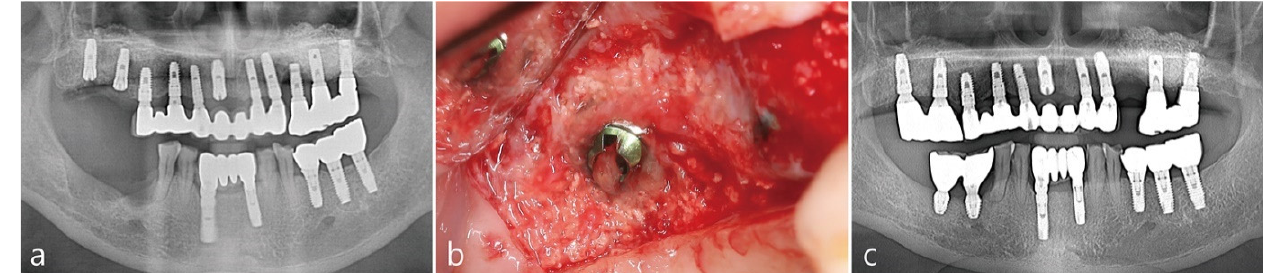
Figure 4. ( a ) Immediate post-operative panoramic radiograph. Intraoral bone augmented around the implant was observed. ( b ) Intra-oral photo taken 6 months post-operatively during the second stage procedure. ( c ) Panoramic radiographs taken two years after prosthesis delivery showed radiographic bone fill around the implant was maintained.